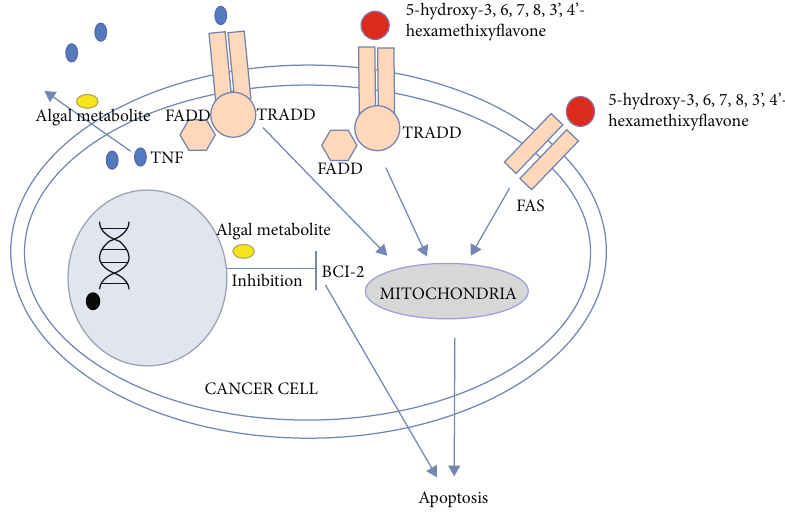
Figure 3: Anticancer activity mechanism algal